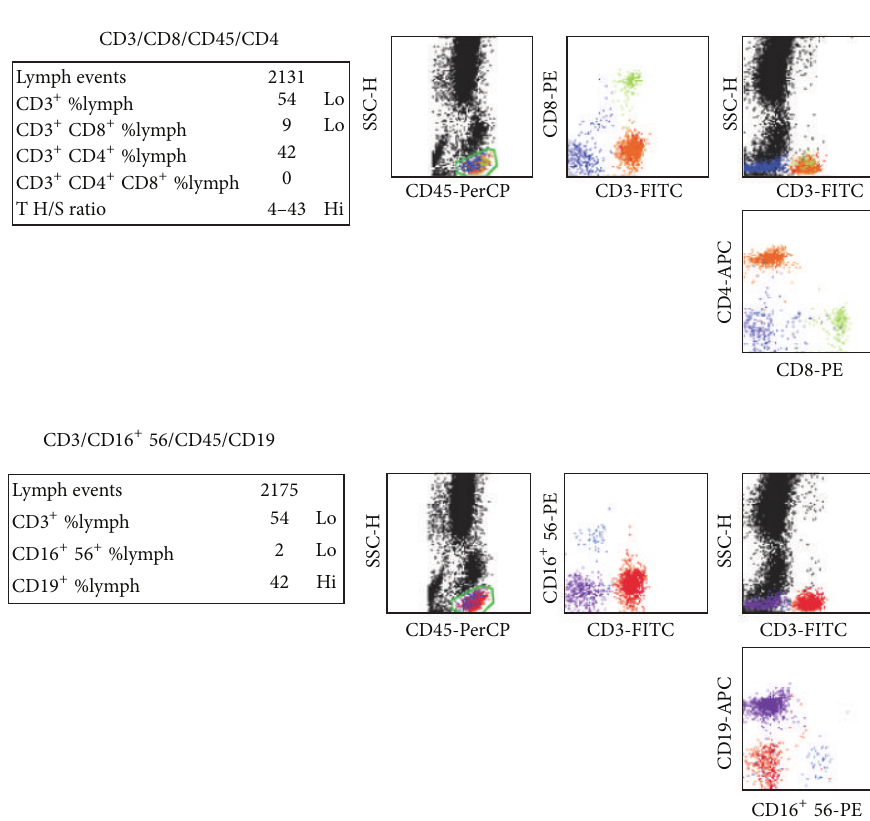
Figure 4: Lymphocyte subset detection by flow cytometry, which showed that the percentages of CD3, CD3/CD8 + , CD3/CD4 + , CD19 + , and NK were 54%, 9%, 42%, 42%, and 2%,